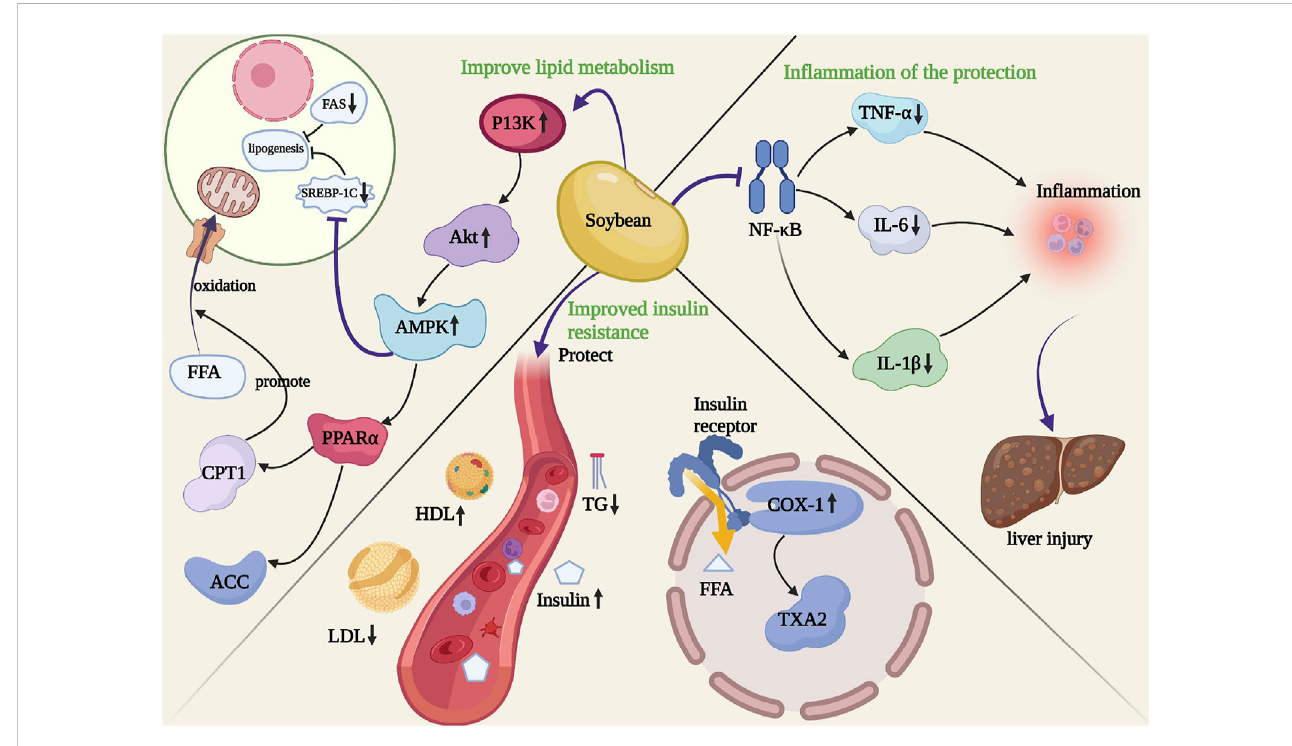
FIGURE 8 Potential molecular mechanisms for the effects of soybean on